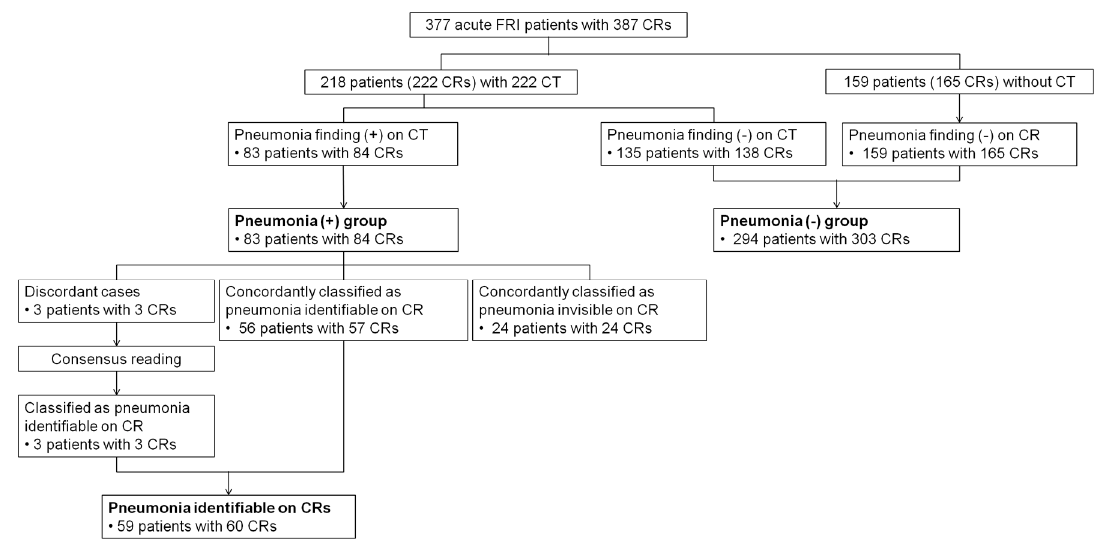
Figure 1. Flow chart for the determination of reference standard. FRI = febrile respiratory illness, CR = chest radiograph, CT = computed tomography